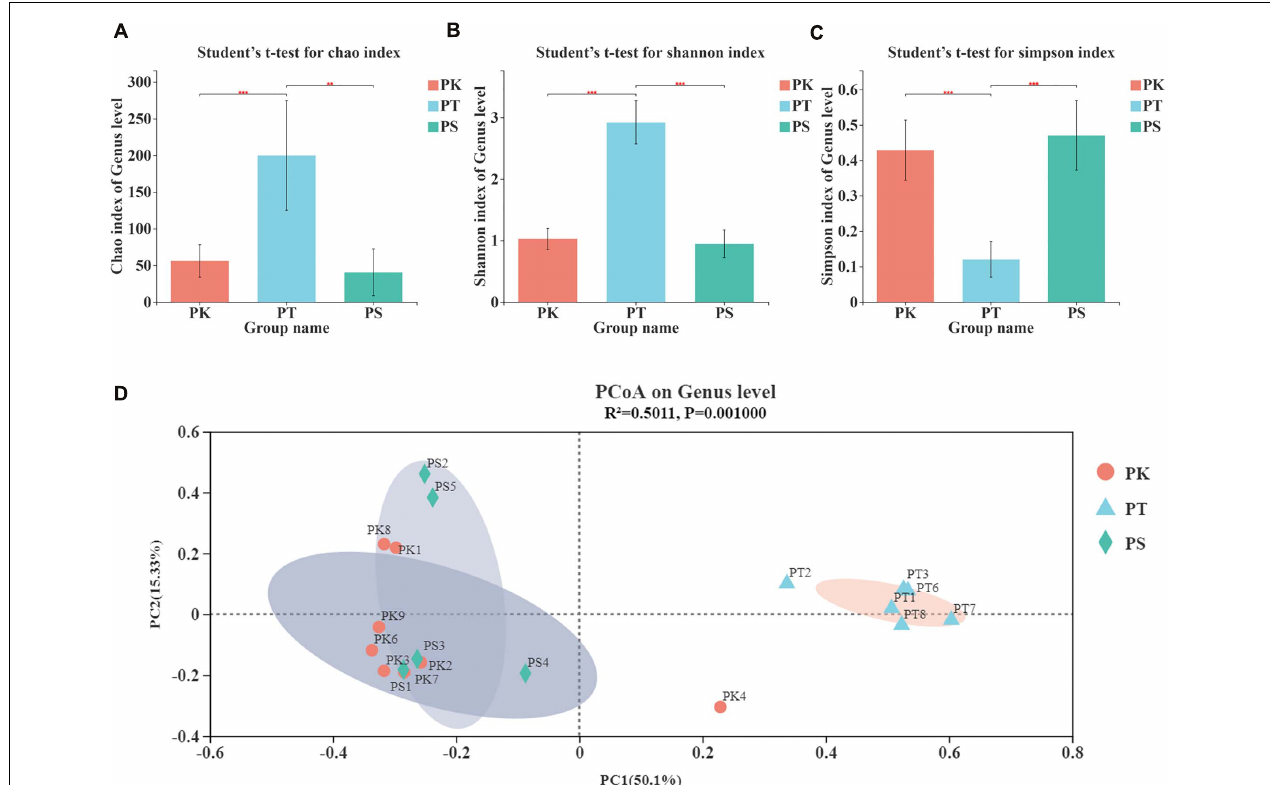
FIGURE 2 | α -diversity and β -diversity of midgut bacteria in M. saltuarius feeding on different host trees. (A) Significant differences in the Chao index (richness estimator). (B) Significant differences in the Shannon index (diversity estimator). (C) Significant differences in the Simpson index (diversity estimator) (Student’s t -test; * P < 0.05, ** P < 0.01, *** P < 0.001). (D) Principal coordinate analysis based on bray_curtis distances generated from OTU tables. Ovals of different colors represent different groupings (adonis; P =